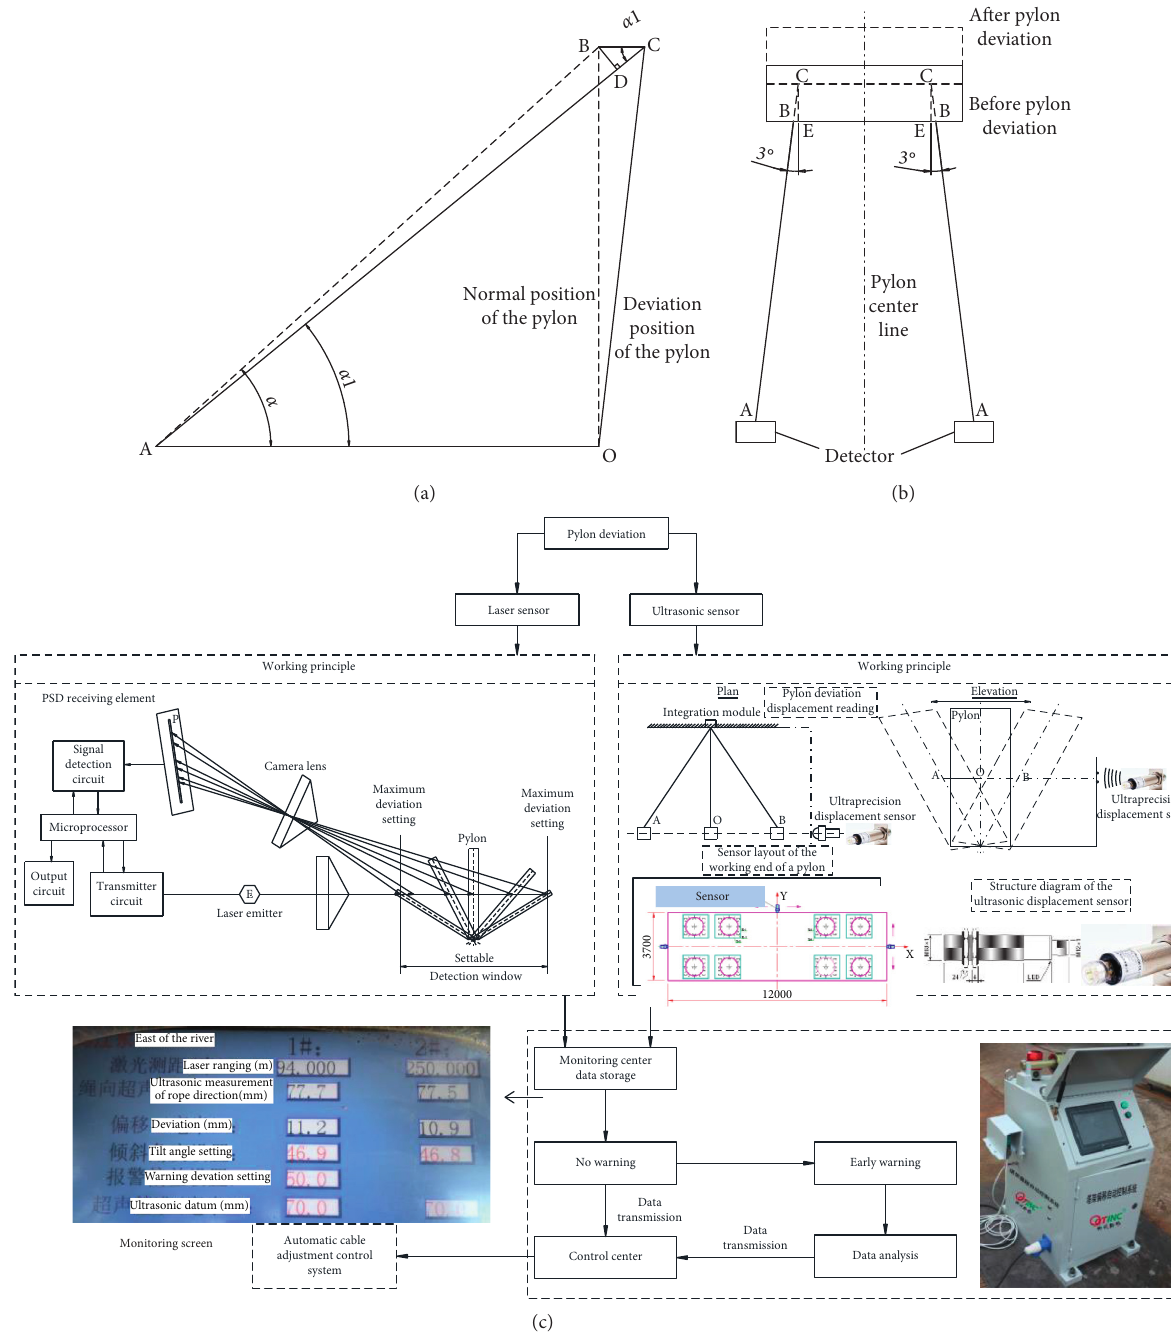
Figure 6: Working principle of the dynamic pylon deviation observation system. (a) Elevation diagram of the pylon deviation. (b) Elevation diagram of the pylon deviation. (c) Flow of the pylon deviation monitoring